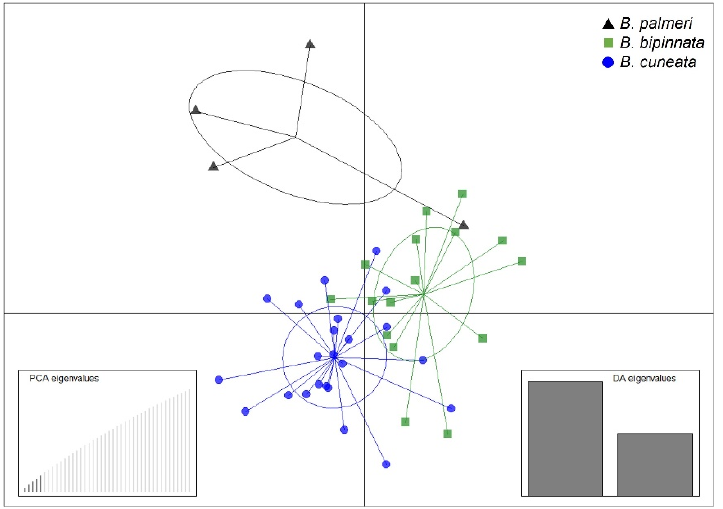
Figure 2. DAPC plot based on 5,543 biallelic SNPs for 43 Bursera individuals. The left inset shows the number of retained PCs, and the right inset denotes the first two discriminant functions used.